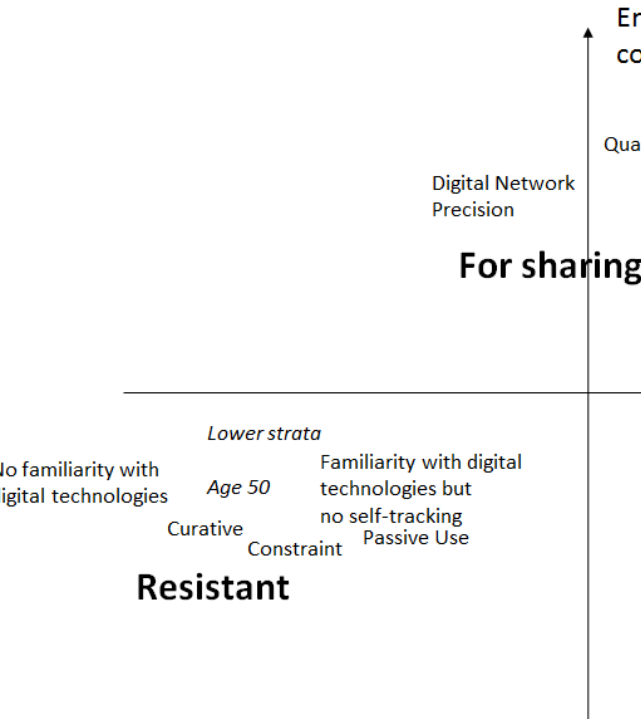
Figure 1. Three types of